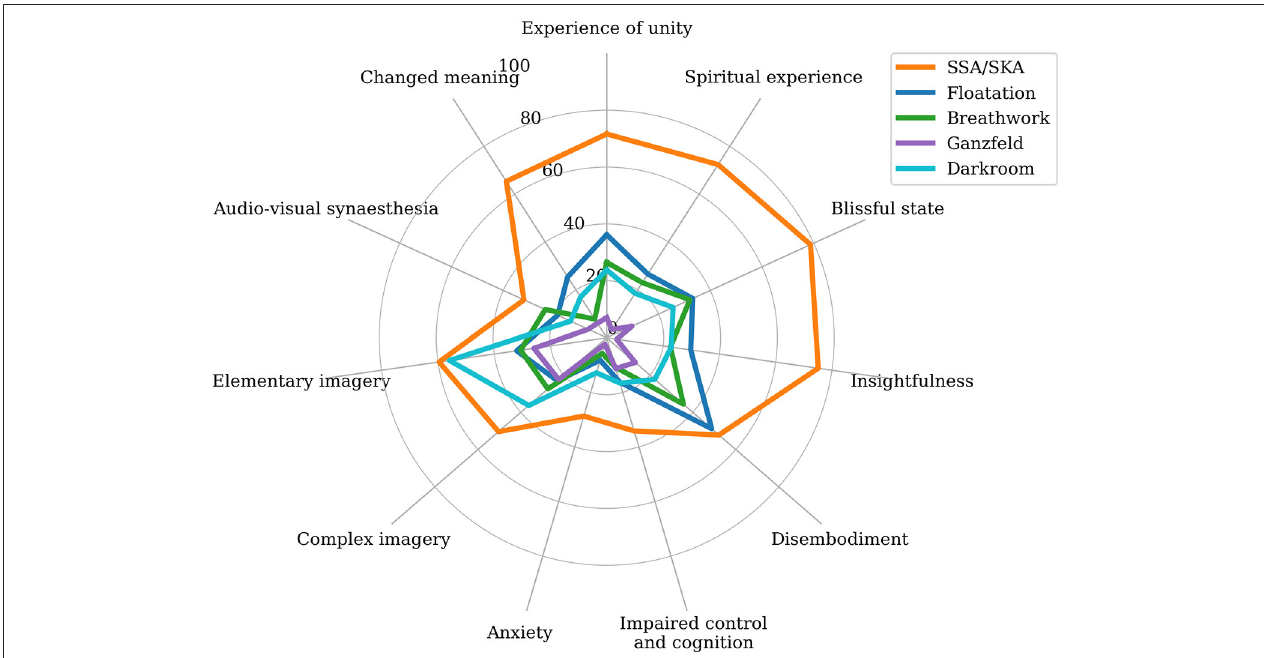
FIGURE 3 | Radar chart comparing the mean subscale scores of the 11-Dimensional Altered States of Consciousness Rating Scale (11D-ASC; Studerus et al., 2010) for the participants of this study (SSA/SKA; N = 152) and for non-drug induced altered states of consciousness (ASCs) produced by the floatation tank (Floatation; 60min; N = 27; Luke et al., 2019); Holotropic Breathwork (Breathwork; 60min; N = 23; Luke et al., 2019); anechoic darkroom (Darkroom; 120min; N = 46; Luke et al., 2018 ); and ganzfeld environment (Ganzfeld; 25min; N = 22; Schmidt and Prein,